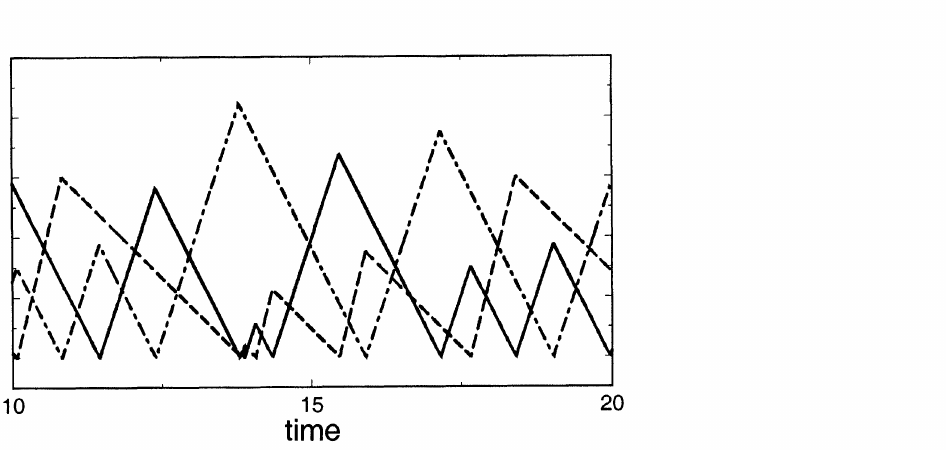
FIGURE 2 The funnel fillings levels x (solid line), x2 (dot-dashed line) and x3 (dashed line) as functions of time. The sum of these values is constant, and x, x2, x3 _> 0. The flow rates are ul u2 0.4, u3 0.2, correspondingly the slopes of the curves are